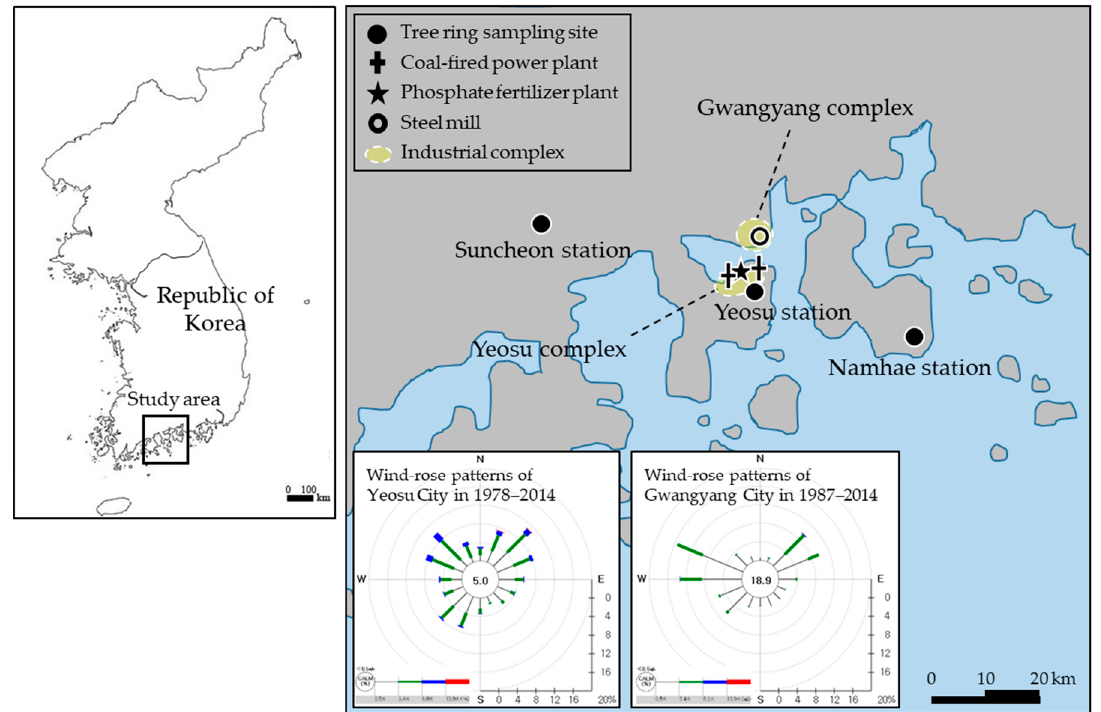
Figure 1. Map of tree ring sampling sites at Yeosu, Namhae, and Suncheon stations and locations of main industrial activities at Yeosu and Gwangyang National Industrial Complexes in southern Korea. Wind-rose patterns represent Hg levels in Yeosu City from 1978 to 2014 and Gwangyang City from 1987 to 2014.